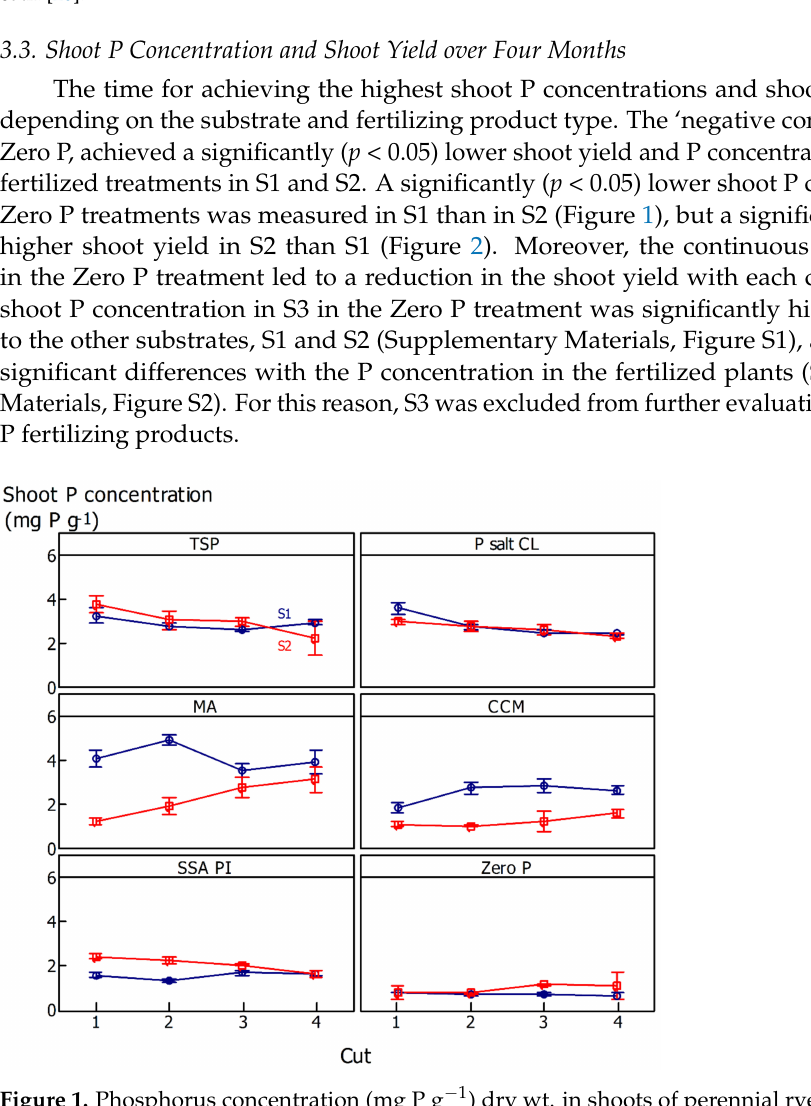
Figure 1. Phosphorus concentration (mg P g − 1 ) dry wt. in shoots of perennial ryegrass as